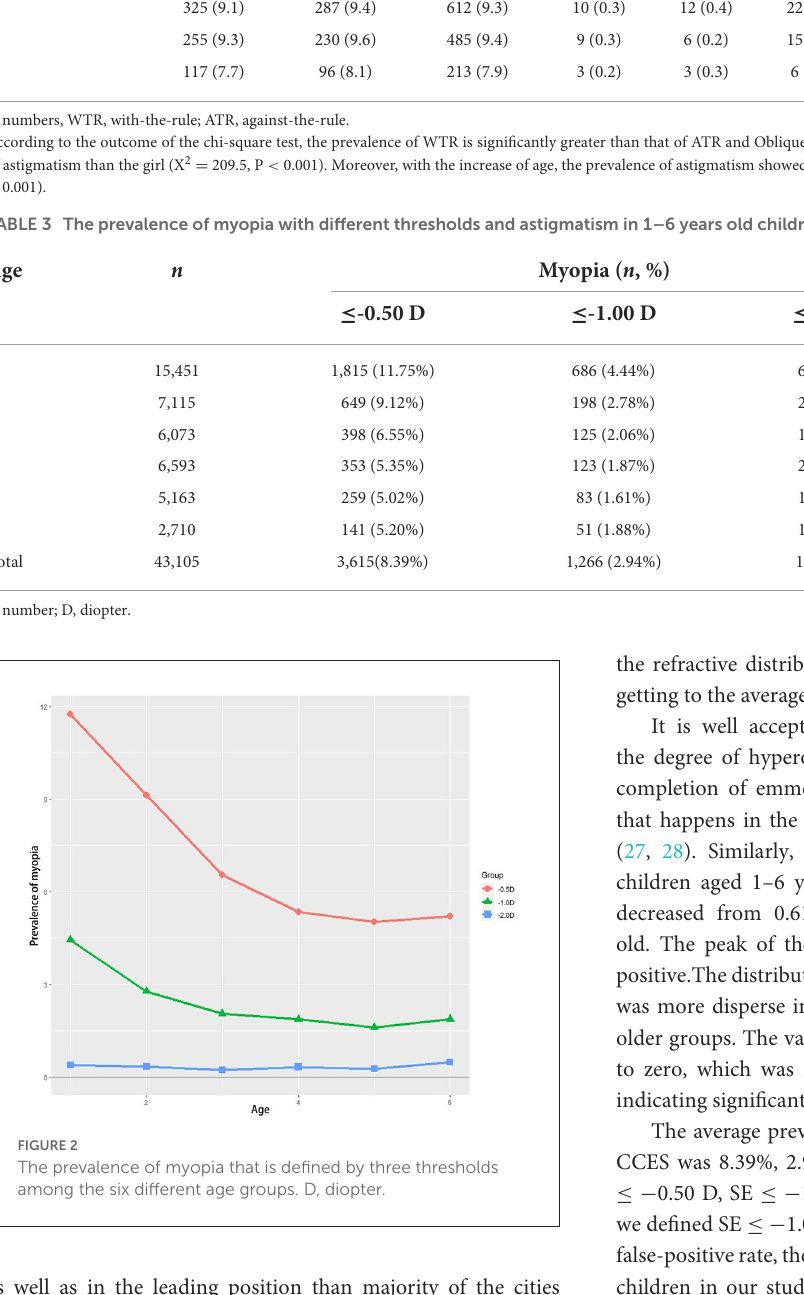
as well as in the leading position than majority of the cities in